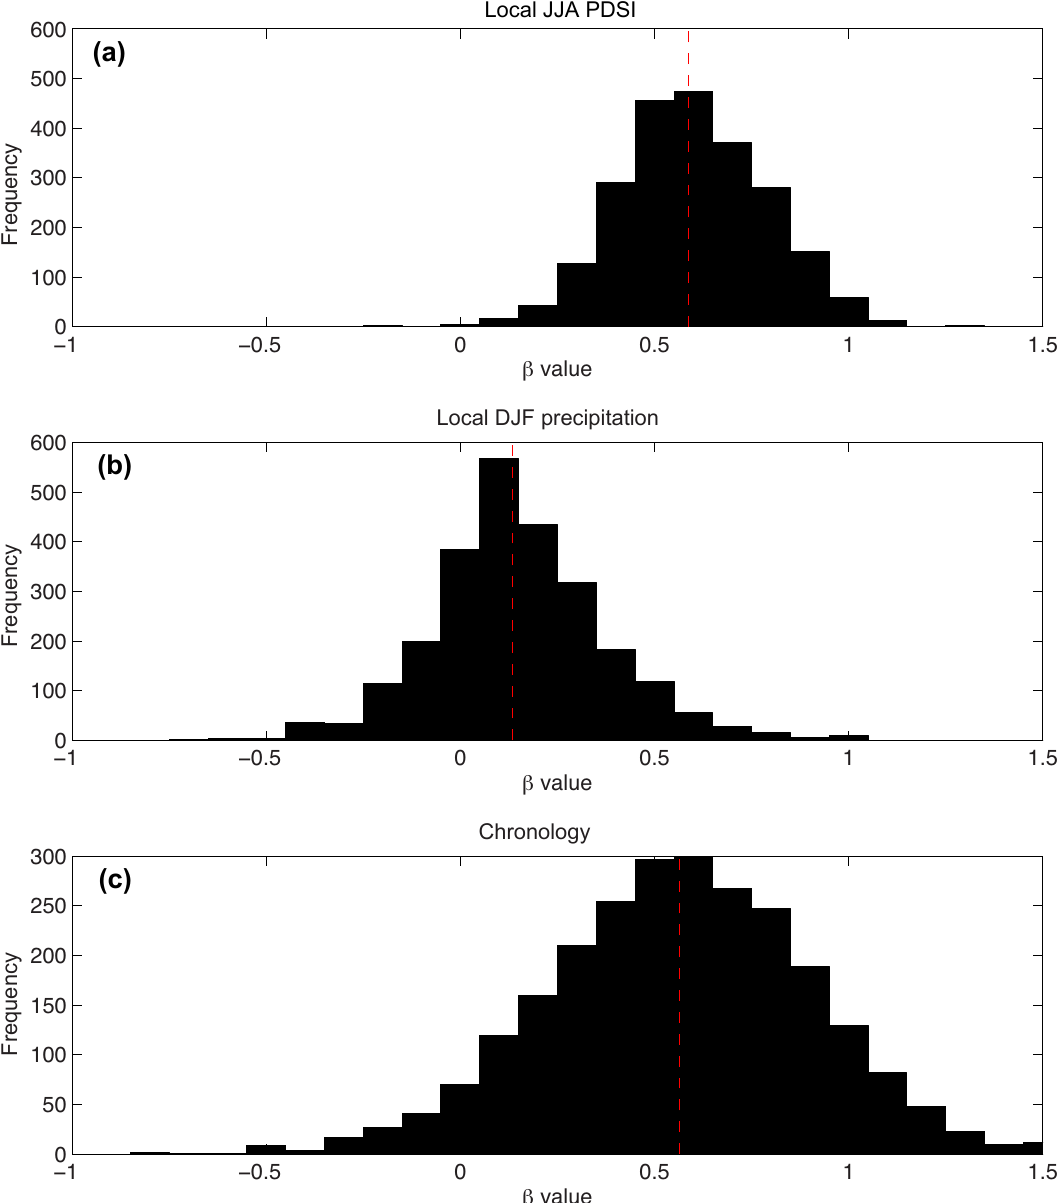
Figure 2. The slope of the multitaper spectrum expressed as β value (Huybers and Curry, 2006) for climate and tree-ring variables at locations with tree-ring chronologies from the North American Drought Atlas (Cook et al., 1999, 2010b), the Monsoon Asia Drought Atlas (Cook et al., 2010a), the Old World Drought Atlas (Cook et al., 2015b), and the Mediterranean and North Africa (Touchan et al., 2011, 2014). (a) β -value frequency distribution for summer (JJA) PDSI from van der Schrier et al. (2011) at tree-ring chronology locations, (b) β -value frequency distribution for winter (DJF) GPCC precipitation (Schneider et al., 2014) at tree-ring chronology locations, and (c) for the tree-ring chronologies themselves. All data were normalized [0,1] over their common interval and their β values were calculated using the multitaper method (Thomson,